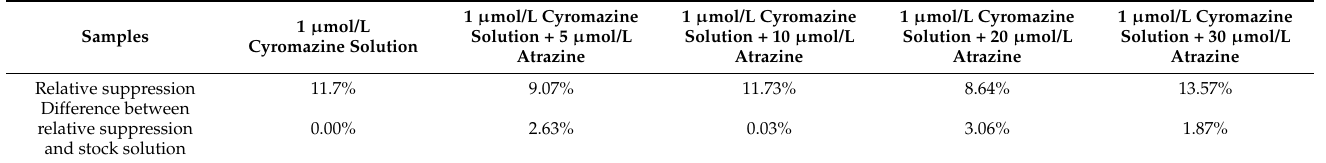
Table 2. The test results of the sensor’s resistance to metolachlor